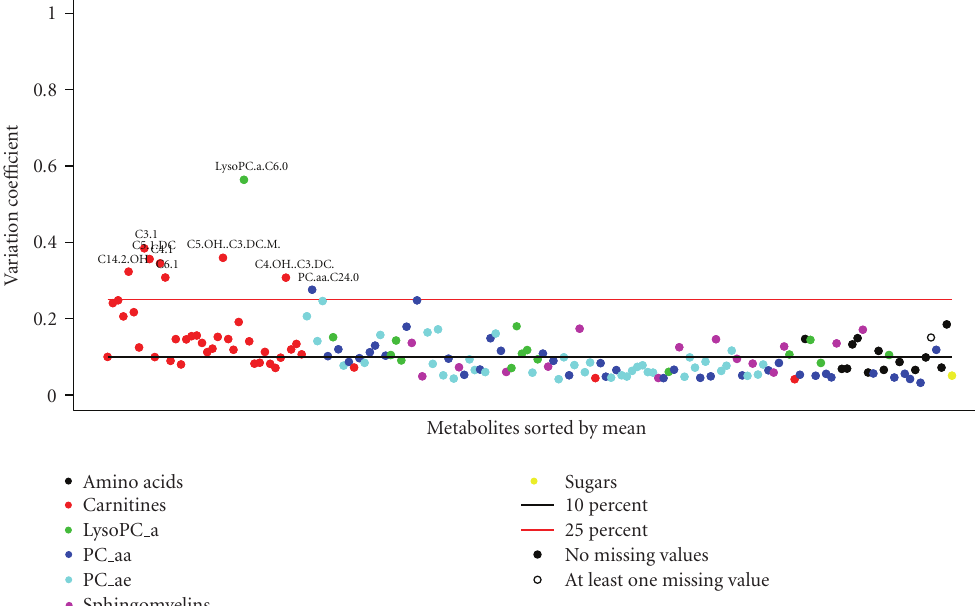
Figure 1: Example for output generated by meta P- server : plot of coe ffi cient of variation for replicated measurement of reference samples (controls) as part of data quality